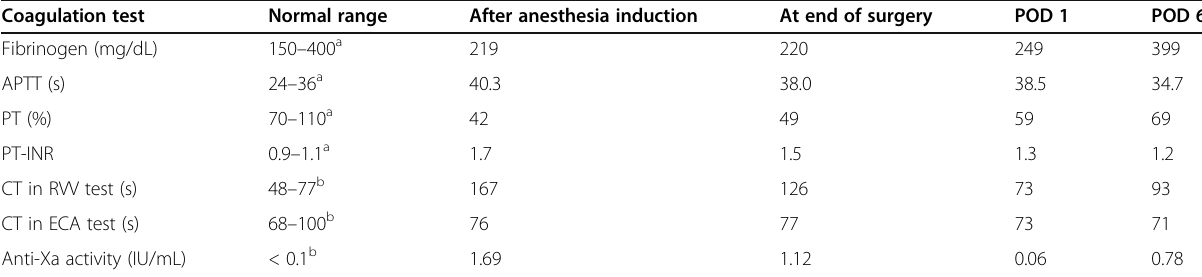
Table 1 Perioperative coagulation tests Coagulation test Normal